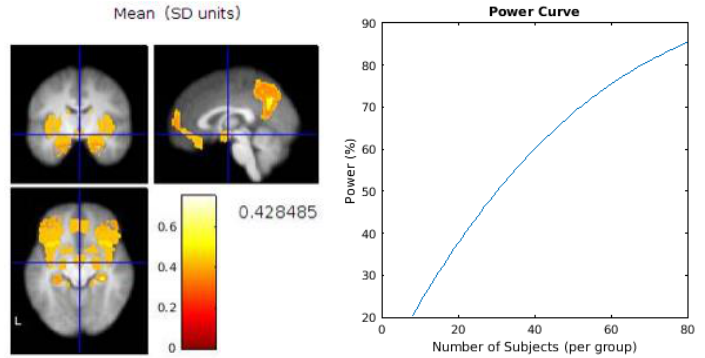
Figure B1. Hippocampus